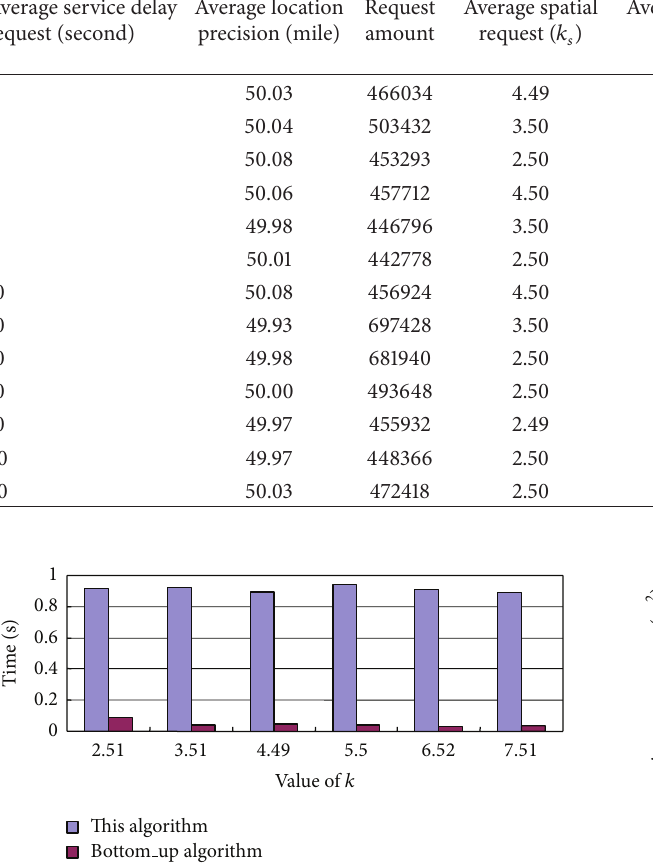
Figure 4: Required processing time for our algorithm and the Bottom up algorithm.